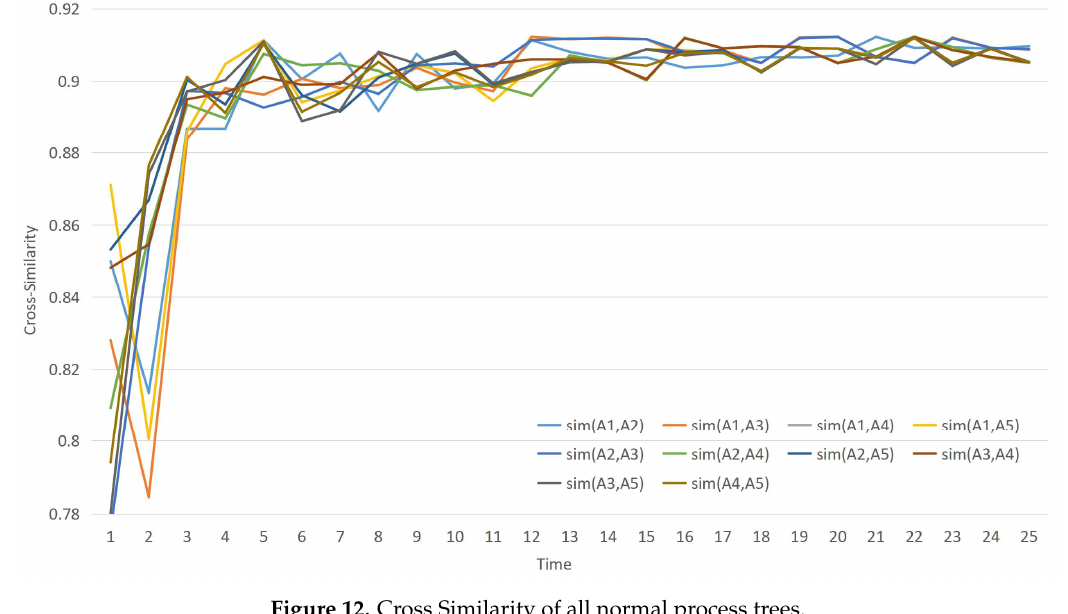
Figure 12. Cross Similarity of all normal process trees.